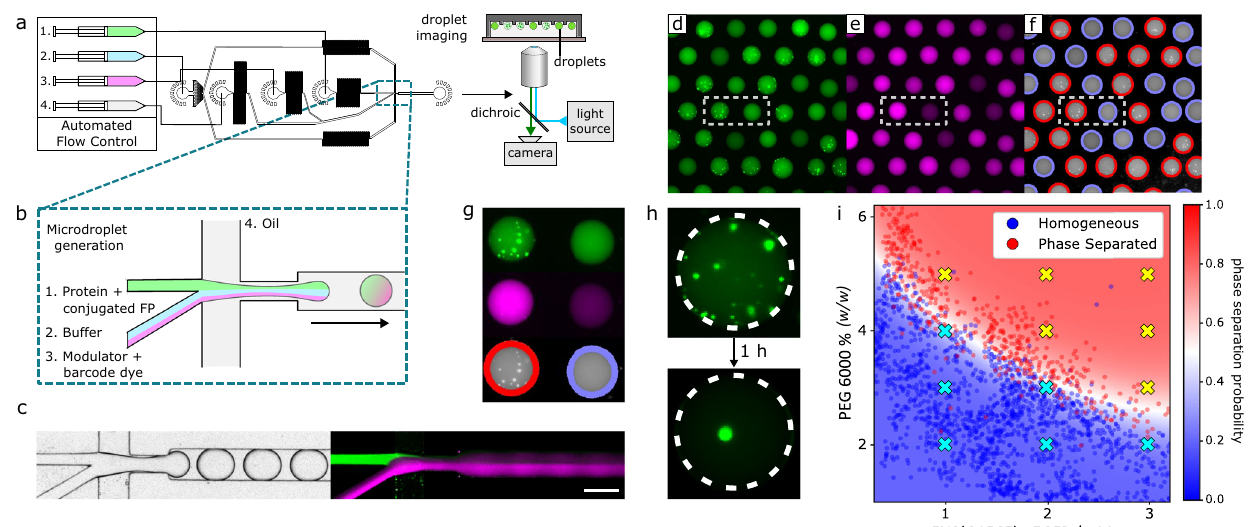
Fig. 1 | PhaseScan work fl ow. a Droplets are generated using a fl ow-focussing micro fl uidic device controlled by automated syringe pumps and then imaged in wells by fl uorescence microscopy. b At the droplet generating junction, aqueous solutions are combined under laminar fl ow before droplet formation. c Bright fi eld microscopy image of droplet generation (left) and combined fl uorescence images of droplet generation (right) showing fl uorescence of EGFP (green) and Alexa647 (magenta) barcodes for FUS G156E and PEG, respectively. d , e Epi fl uorescence microscopy images of trapped microdroplets, with EGFP and Alexa647 fl uores- cence corresponding to FUS G156E and PEG concentration, respectively. f Classi fi cation of droplets asphase separated (red outline) or homogeneous (blue outline) according to distribution of EGFP fl uorescence. g Phase separated (left) and homogeneous (right) microdroplets imaged according to EGFP (top) and